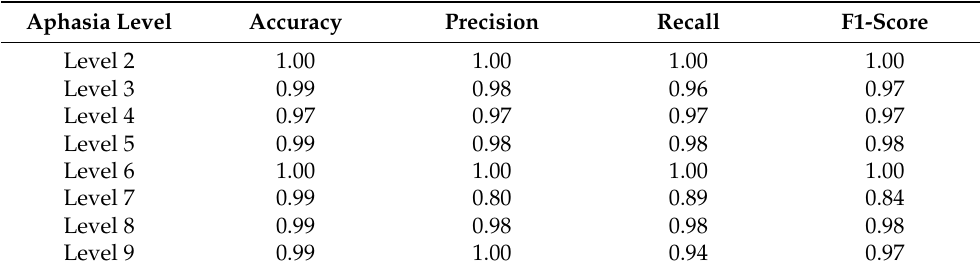
Table 9. Classification report of DNN model for aphasia severity level classification using 10 s audio chunks whose audio features are extracted using MFCC. Aphasia Level Accuracy Precision